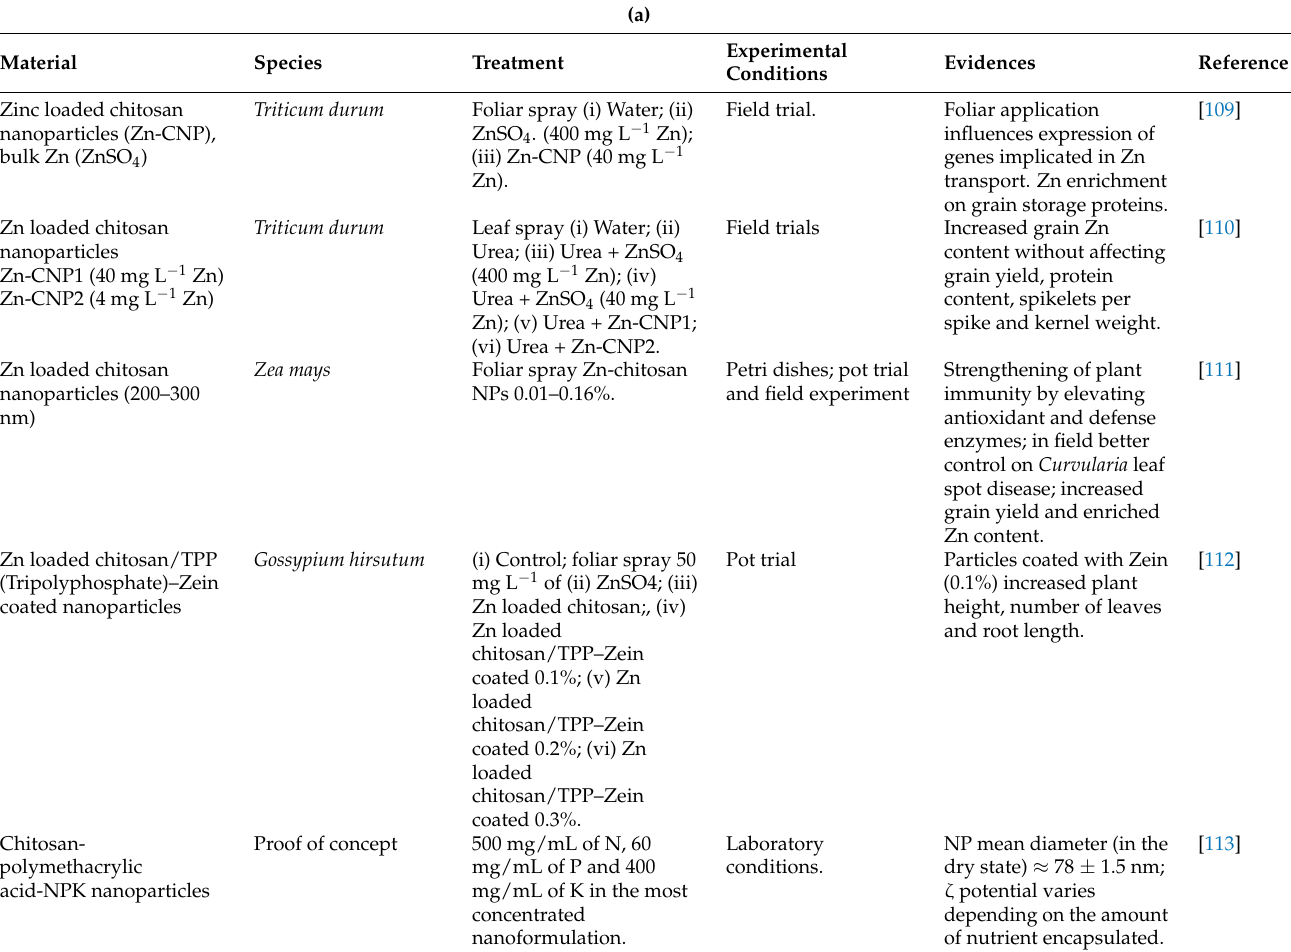
Table 6. Chitosan nanoparticles loaded with